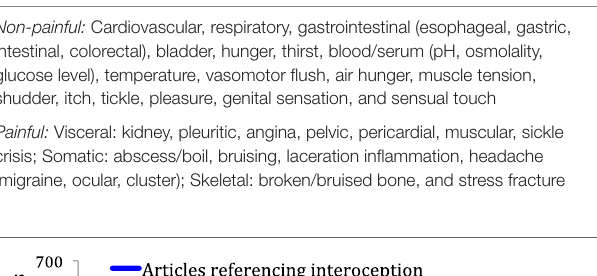
TABLe 3 | Physiological processes that have been ascribed to